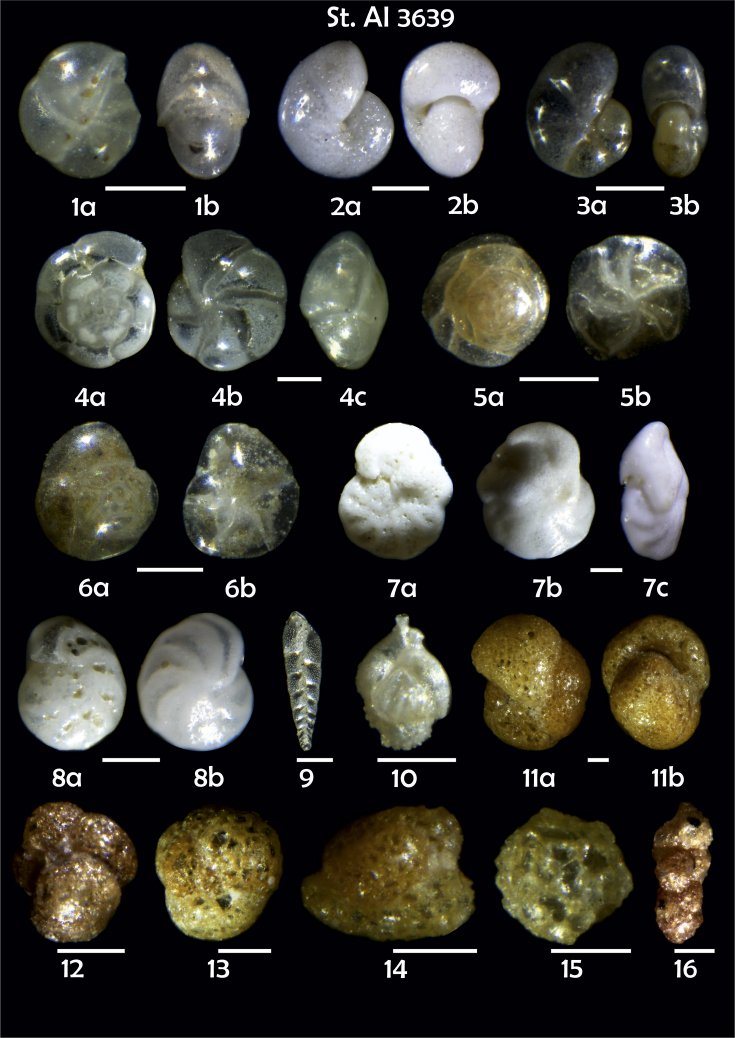
Station 36391Pullenia quinqueloba, a side view, b apertural view. 2Melonis pompilioides, a side view, b apertural view. 3Pullenia sp., a umbilical view, b apertural view. 4Oridorsalis umbonatus, a spiral view, b lateral view, c apertural view. 5Alabaminella weddellensis, a spiral view, b umbilical view. 6Epistominella exigua, a spiral view, b umbilical view. 7Cibicidoides pseudoungeriana, a umbilical view, b spiral view, c apertural view. 8C. wuellerstorfi, a umbilical view, b spiral view. 9Bolivina earlandi.10Uvigerina sp. 11Cribrostomoides subglobosus, a lateral view, b apertural view. 12 ?. 13 ?. 14Adercotryma glomeratum. 15Psammosphaera fusca. 16Karrerulina conversa. Scale 100 μm.